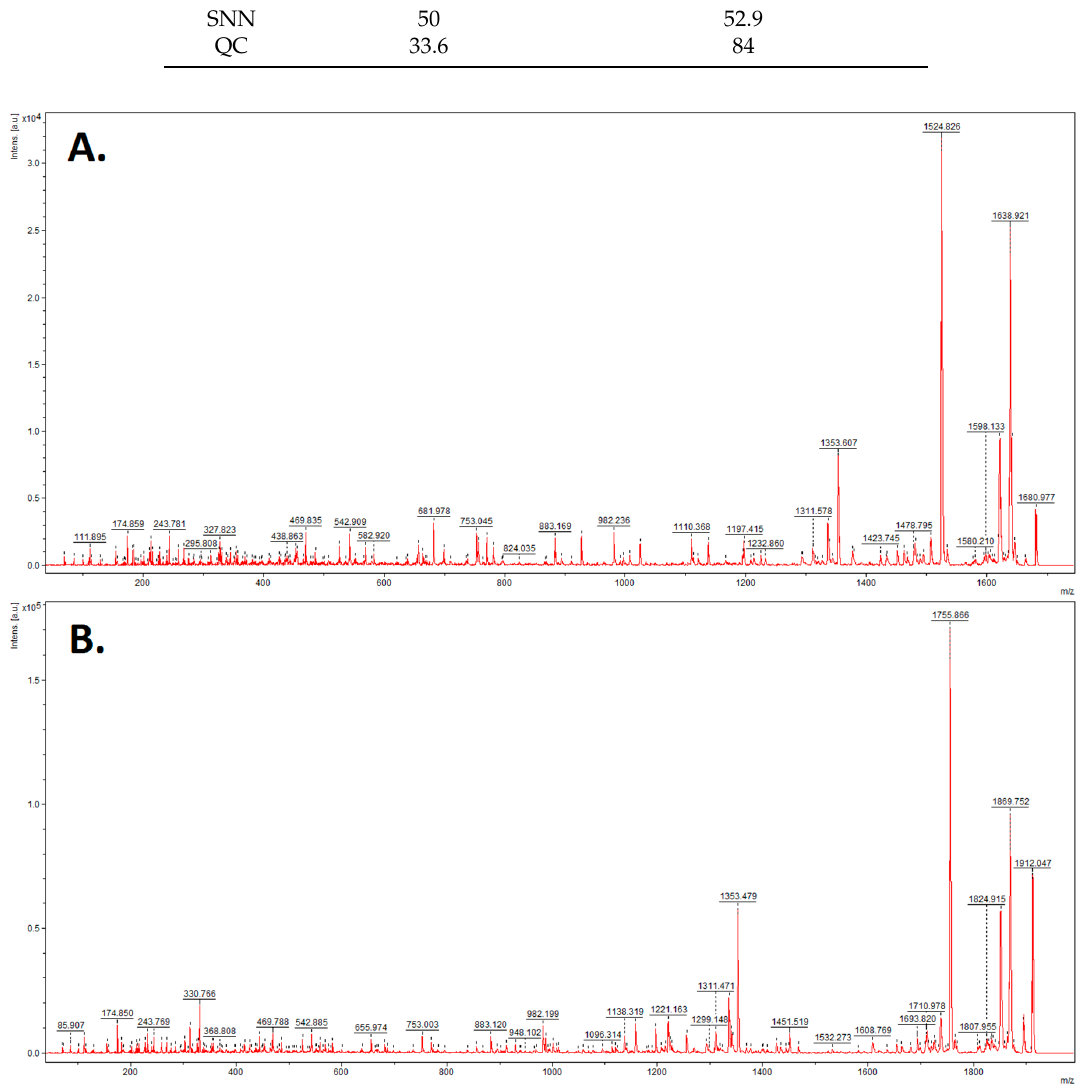
Figure 5. Fragmentation spectra of precursor ions of ( A ) m / z = 1682.34; ( B ) m / z = 1913.54 identified as uromodulin.